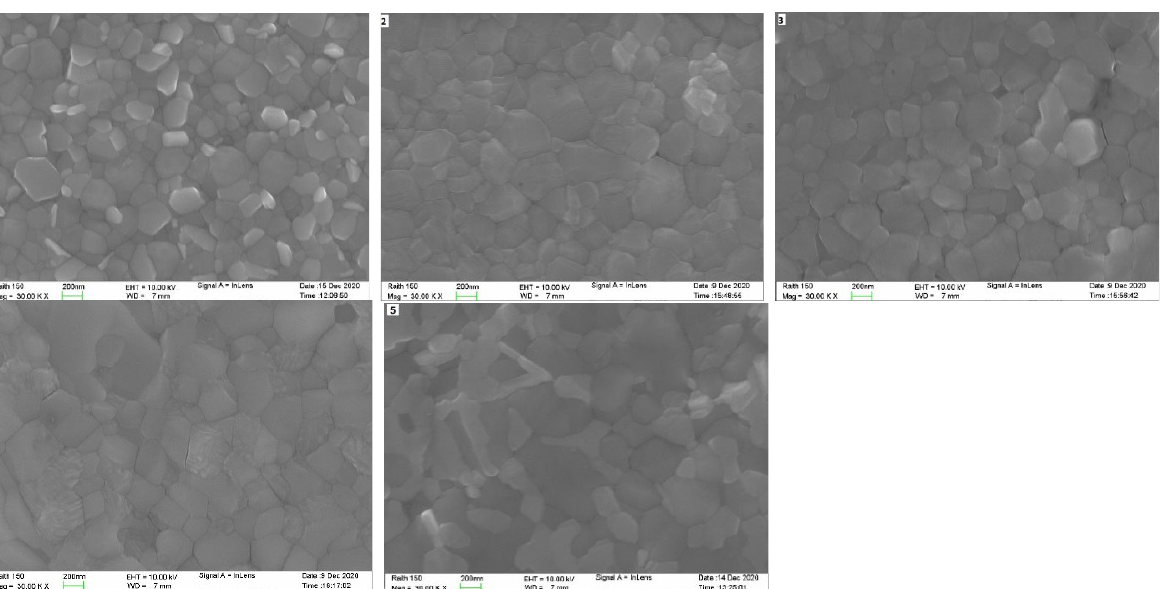
Figure 9. SEM images of the perovskite active layers prepared with different compositions for the 5 samples as detailed in Table 1 and are numbered accordingly.